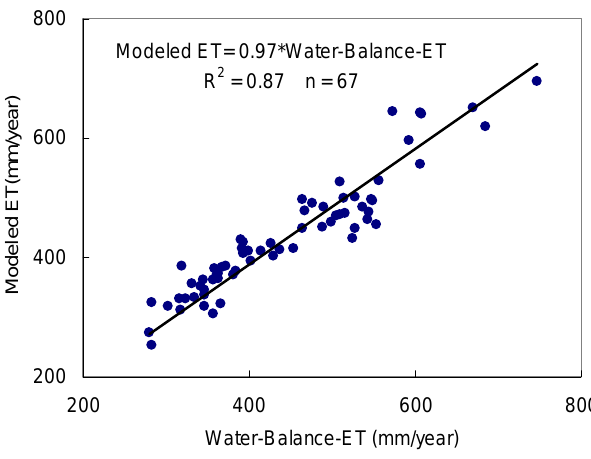
Fig. 3. ET Model validation using Water-Balance-ET data derived Fig. 3 ET Model validation using Water-Balance-ET data derived from hydrometeological data from hydrometeological data across the Loess Plateau across the Loess Plateau region